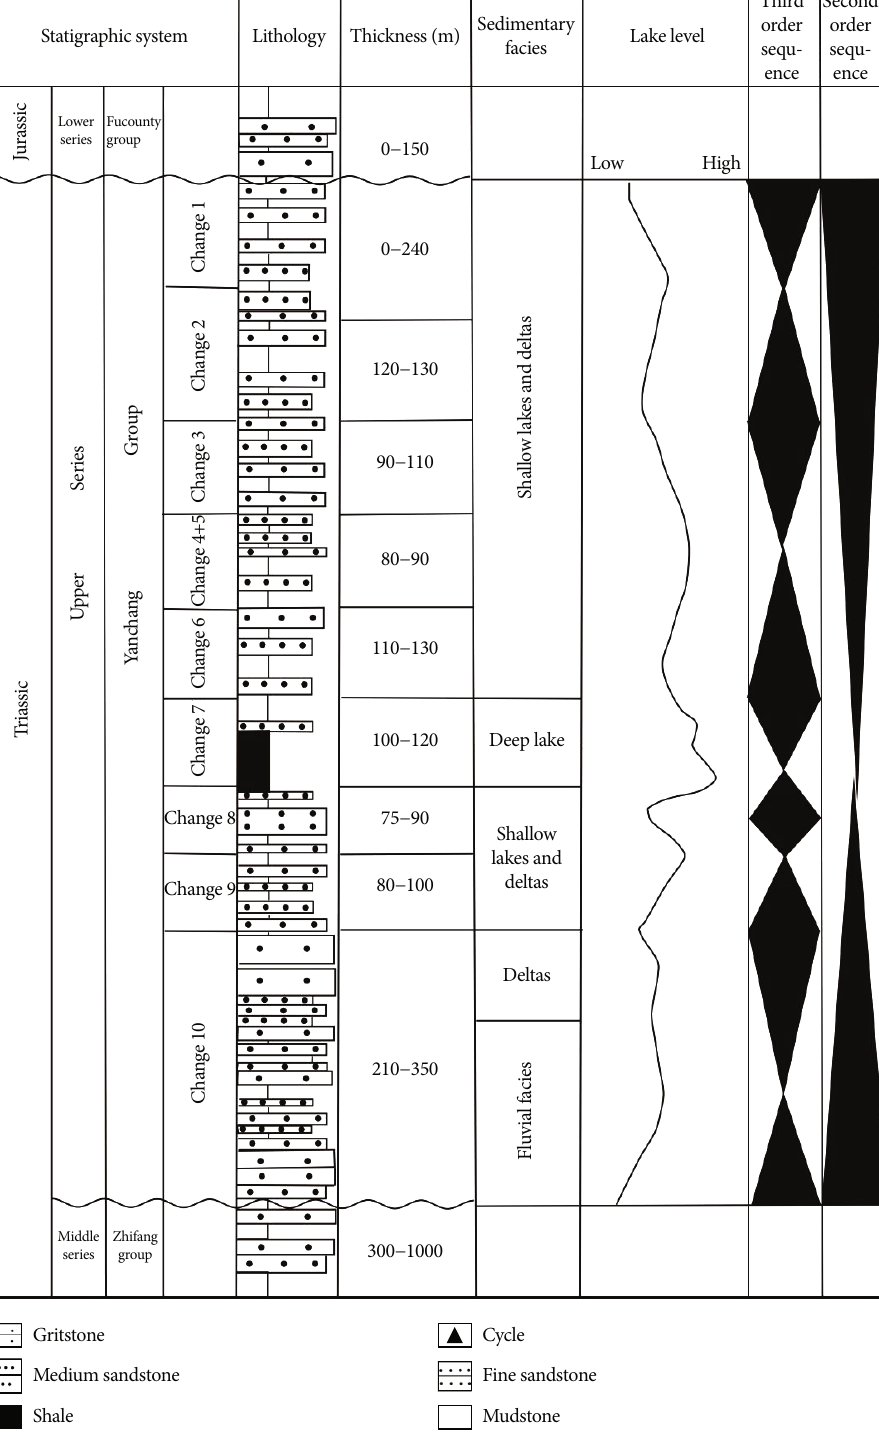
Figure 2: Brief stratigraphic map of the Yanchang Group (modi fi ed from Changqing Oil